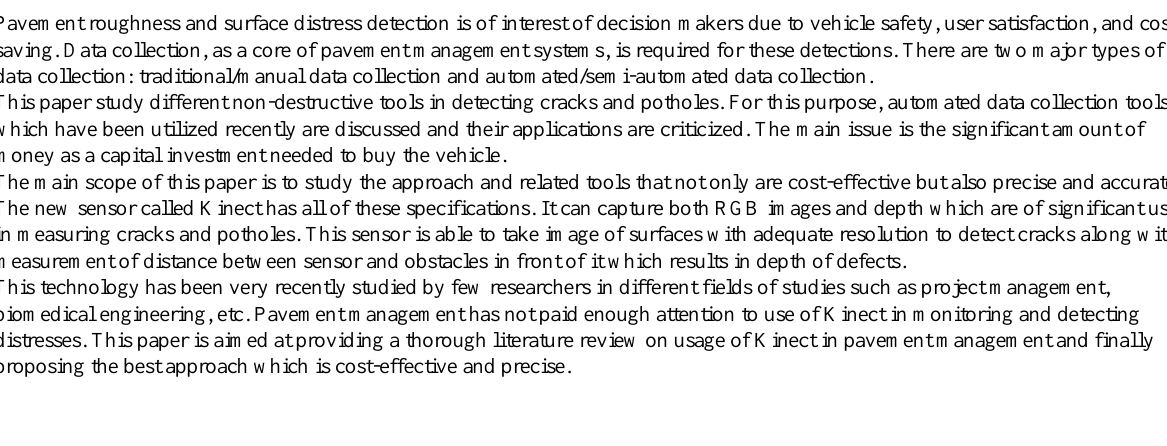
Table 1 Type of cracks and potholes in asphalt